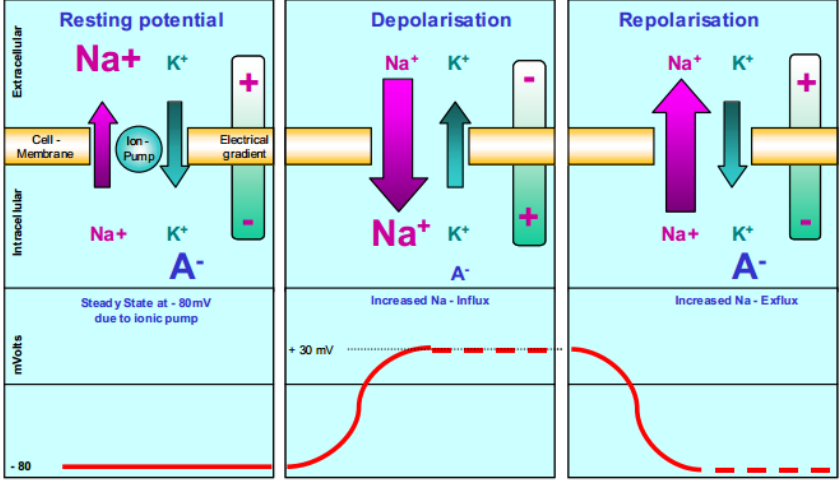
Figure 2. Schematic illustration of repolarization/depolarization cycle within excitable